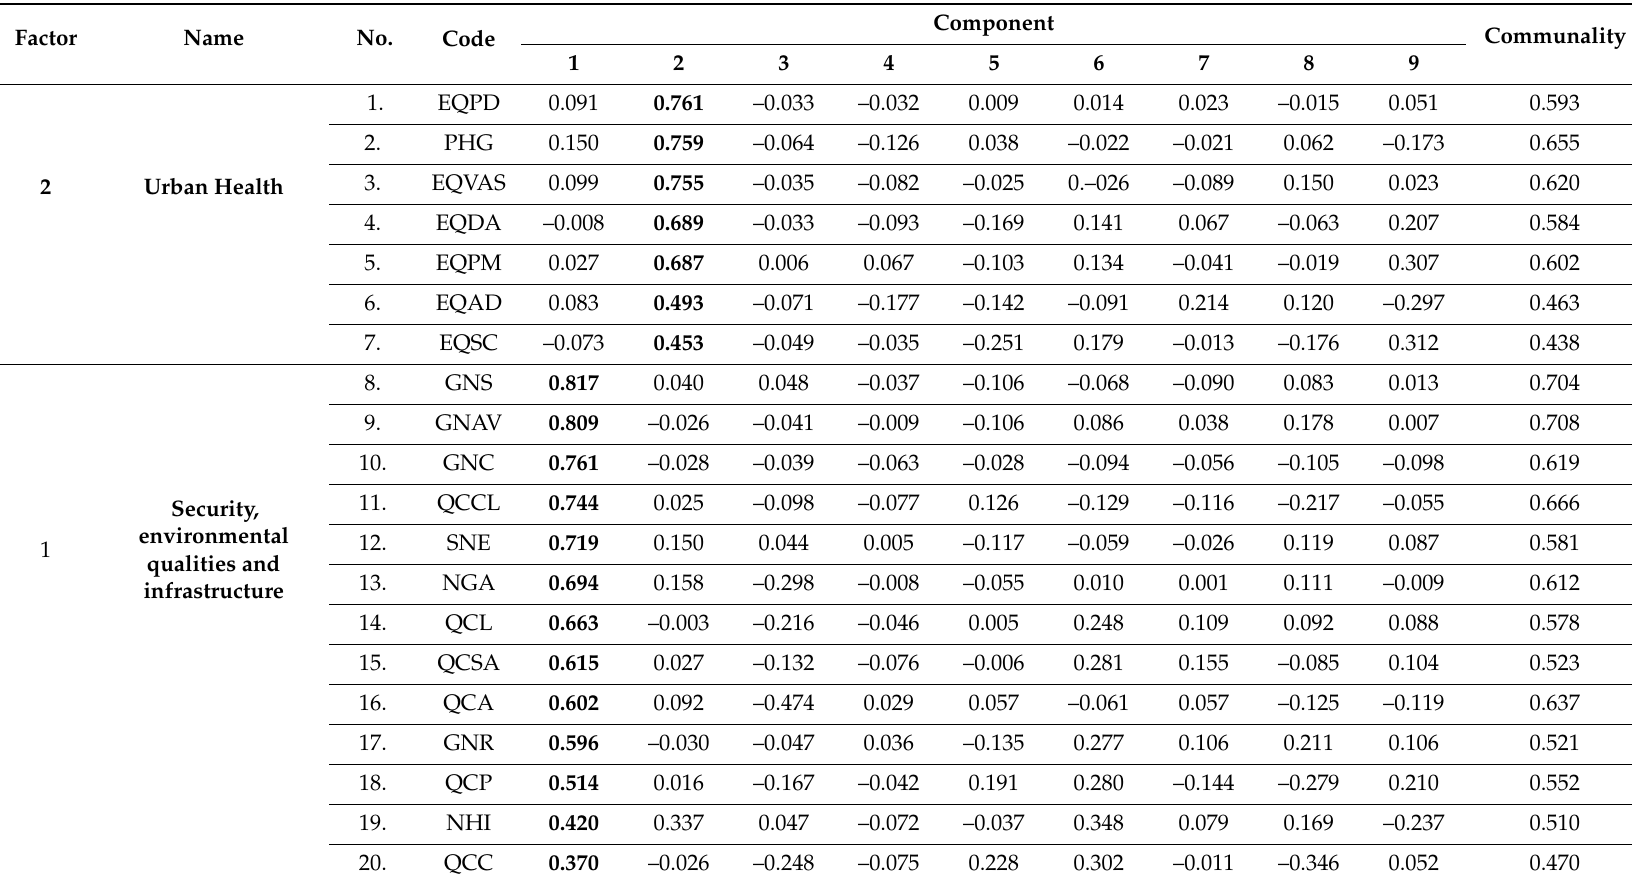
Table 2. Factor loadings and communalities from principal component analysis (PCA) (nine PCs, rotation converged in six